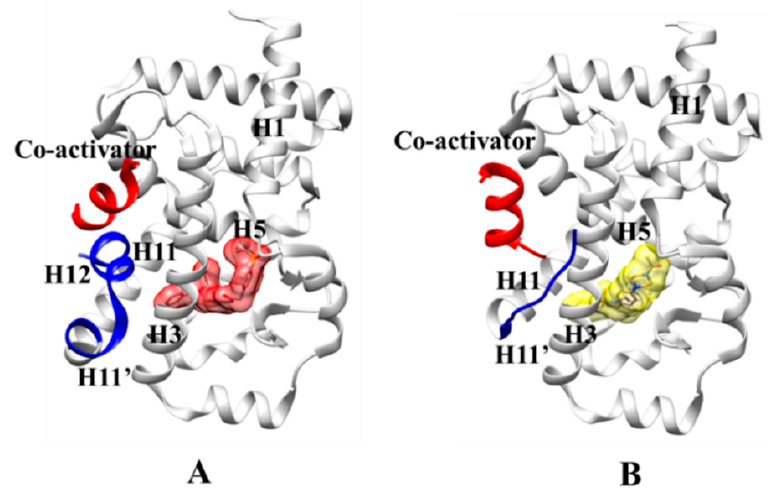
Figure 1. 3D structures of ROR γ t-ligand-binding domain (ROR γ t-LBD) binding agonist and inverse agonist. The white color stands for H1 to H11, the blue color stands for H11 ′ and H12, and the red color stands for co-activator. ( A ) ROR γ t-agonist complex, the agonist is in salmon; ( B ) ROR γ t-inverse agonist complex, the inverse agonist is in yellow.